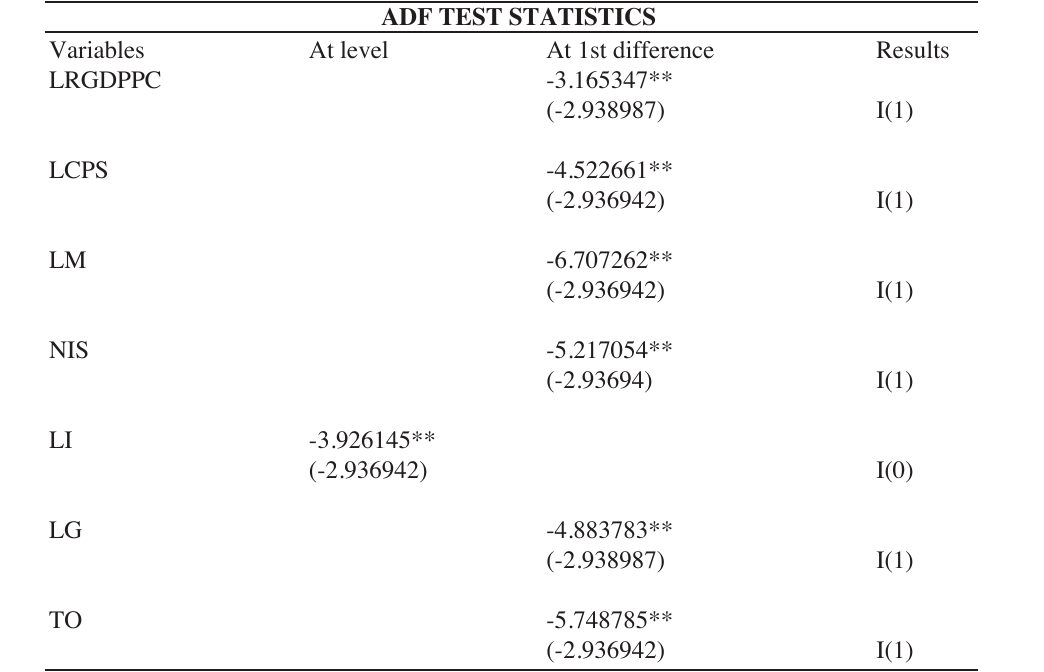
Table 3: Augmented Dicky Fuller test